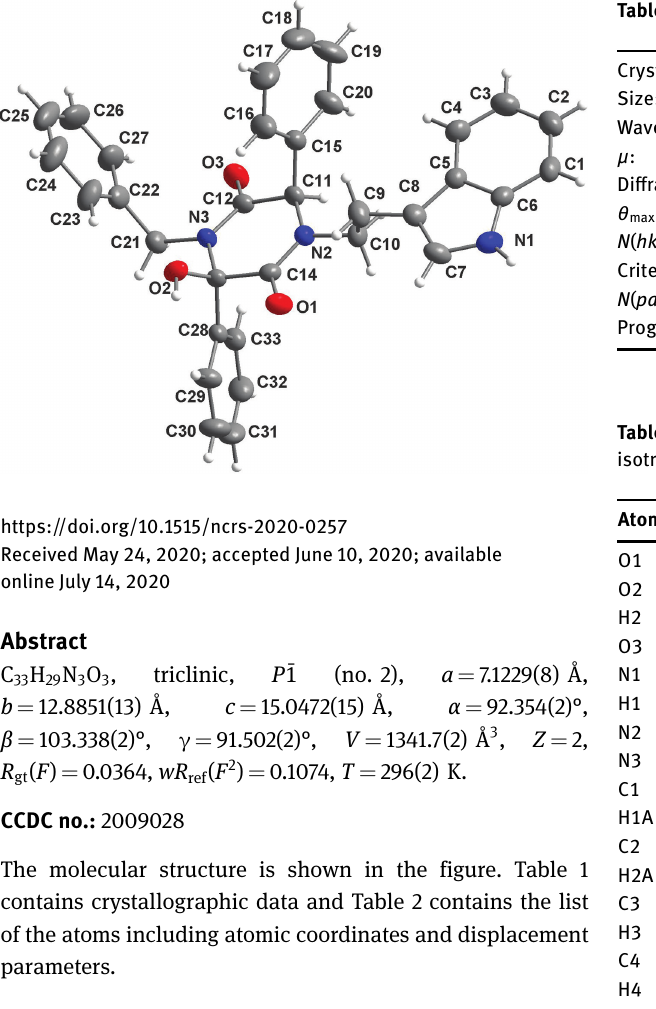
Table 1: Data collection and handling.